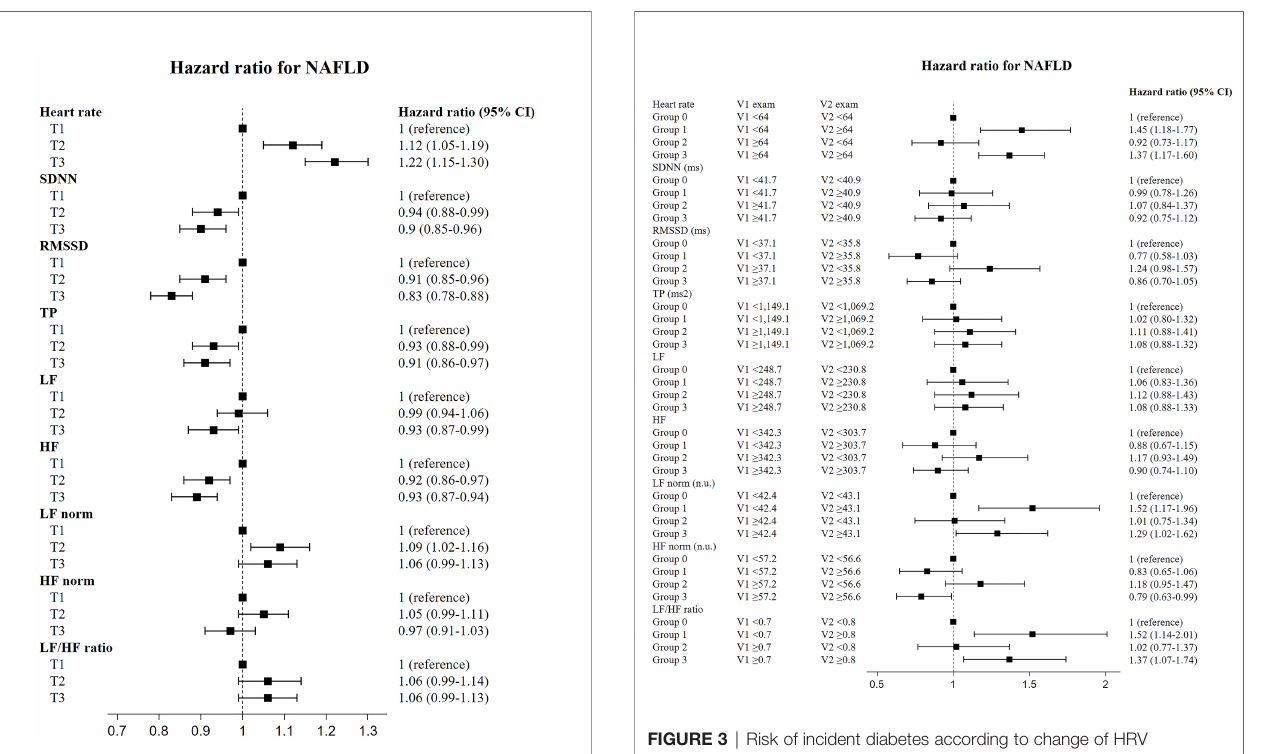
( Supplementary Tables 4 , 5 , respectively).